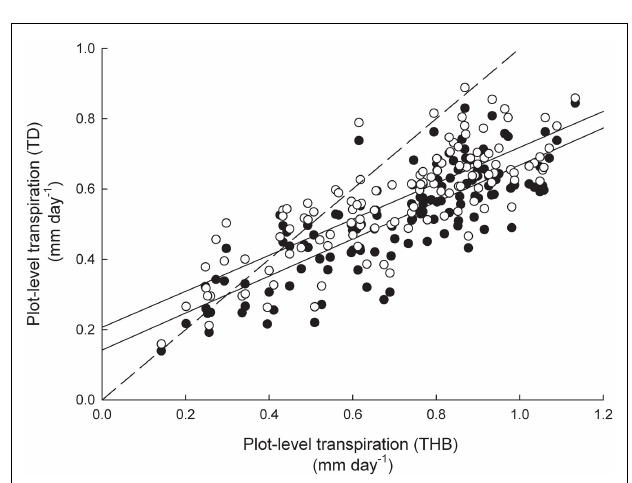
FIGURE 6 | Plot level estimates of daily transpiration (mmday − 1 ) for 2009 derived from tissue heat balance (THB) sap flow data vs. estimates derived from thermal dissipation (TD) sap flow data. Closed circles denoteTD data with the Clearwater correction applied to all Quercus sp. and open circles denoteTD data where Q. prinus 2-cm long sensors are corrected with 1-cm data regression ( Figure 4A ) and all other Quercus sp. received the Clearwater correction.The dashed line is the one to one line, and the solid lines are the best fit regressions for the Clearwater-corrected TD data ( y = 0.66 x + 0.13, r 2 = 0.43) and the 1-cm correctedTD data ( y = 0.66 x + 0.18, r 2 = 0.44).